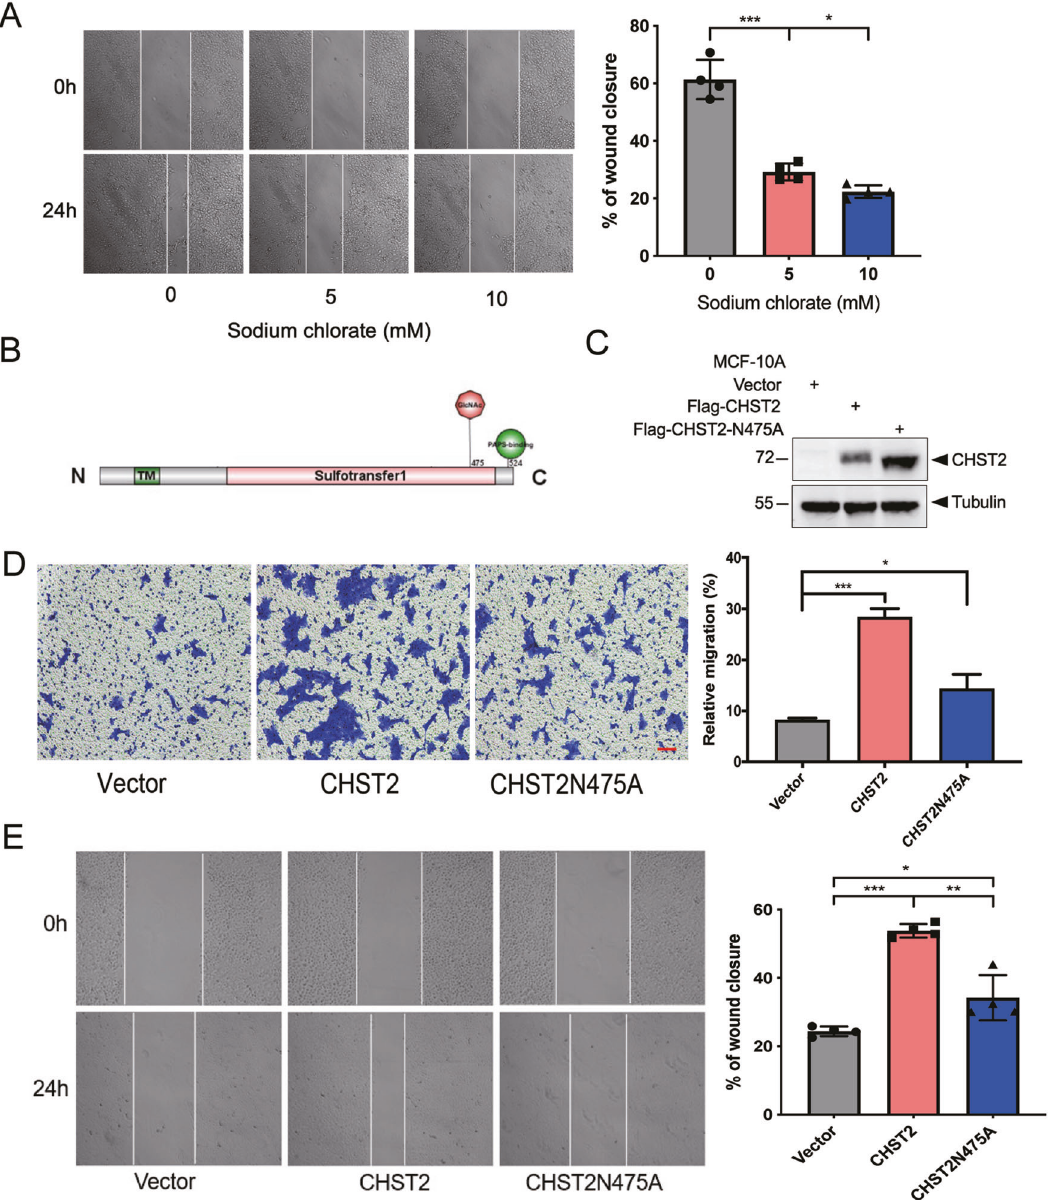
Fig. 3 CHST2 promotes cell migration in an enzymatic-dependent manner. A The wound-healing assay showed migration capabilities of CHST2-overexpressed MCF-10A cells in the presence of 0, 5, 10 mM sodium chlorate for 48 h. Left panel: Representative images were shown. Right panel: The quanti fi cation of the percentage of wound closure. Data were shown as mean ± SD from four independent experiments, *** P < 0.001, * P < 0.05, Students t test. B The diagram of CHST2, the site of N475 which can be mono-glycosylated is critical for enzyme activity. C Western blots (WB) showed the protein level of MCF-10A-Vector, WT CHST2 and mutant CHST2-N475A cells in total cell lysates (TCL). D Transwell assays were performed in stable cell lines. Six fi elds chosen randomly were counted for statistical analysis. Data were shown as mean ± SD from three independent experiments. *** P < 0.001, * P < 0.05, Students t test. E Wound-healing assay showed the migration abilities of MCF-10A-Vector, CHST2 or mutant CHST2-N475A cells, left panel: Representative images were shown. Right panel: The quanti fi cation of the percentage of wound closure, Data were shown as mean ± SD. of four independent experiments, *** P < 0.001, ** P < 0.01, * P < 0.05.